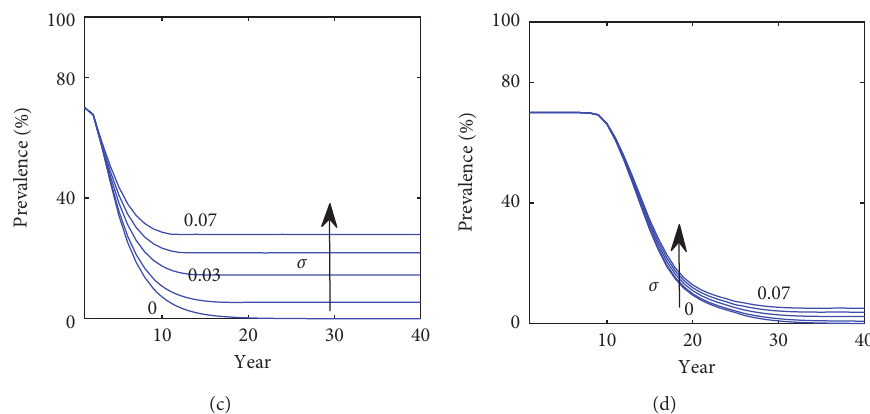
Figure 7: Dynamics of prevalence without ( σ � 0 ) or with external infection source ( σ � 0 . 01 , 0 . 03 , 0 . 05 , 0 . 07 ) in baseline case: (a) three control cases, (b) medication, (c) test-and-cull, and (d) vaccination. Arrow shows σ increases from 0, 0.01, 0.03, and 0.05 to 0.07, and other parameters are used according to Table